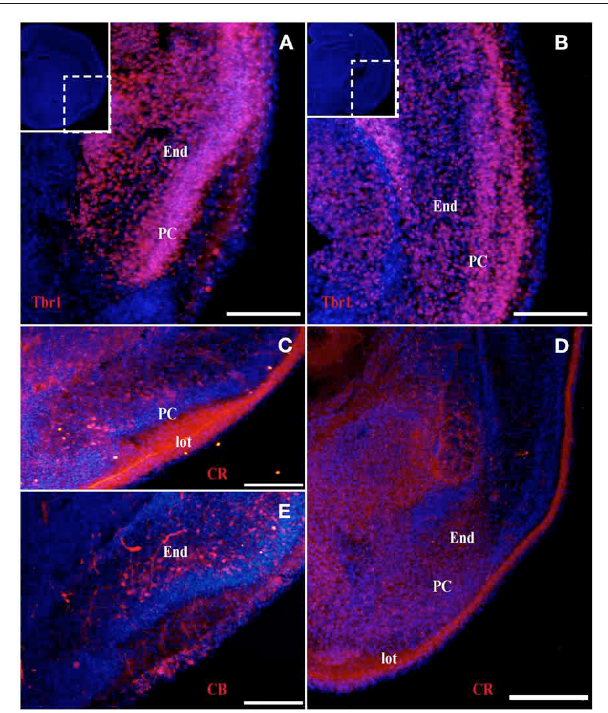
FIGURE 3 | Tbr1, CR, and CB (red) expression in the olfactory cortex at E18. (A–D) Tbr1 and CR expression in the rostral and the caudal regions of the piriform cortex. Both Tbr1 and CR are expressed in the End (A,B,D) , whereas only CR is expressed in the lot (C) . (E) CB is only expressed in the End. Coronal sections; midline is to the left and dorsal is up. Blue corresponds to the bisbenzimide counterstaining. Scale bars: 500 µ m.